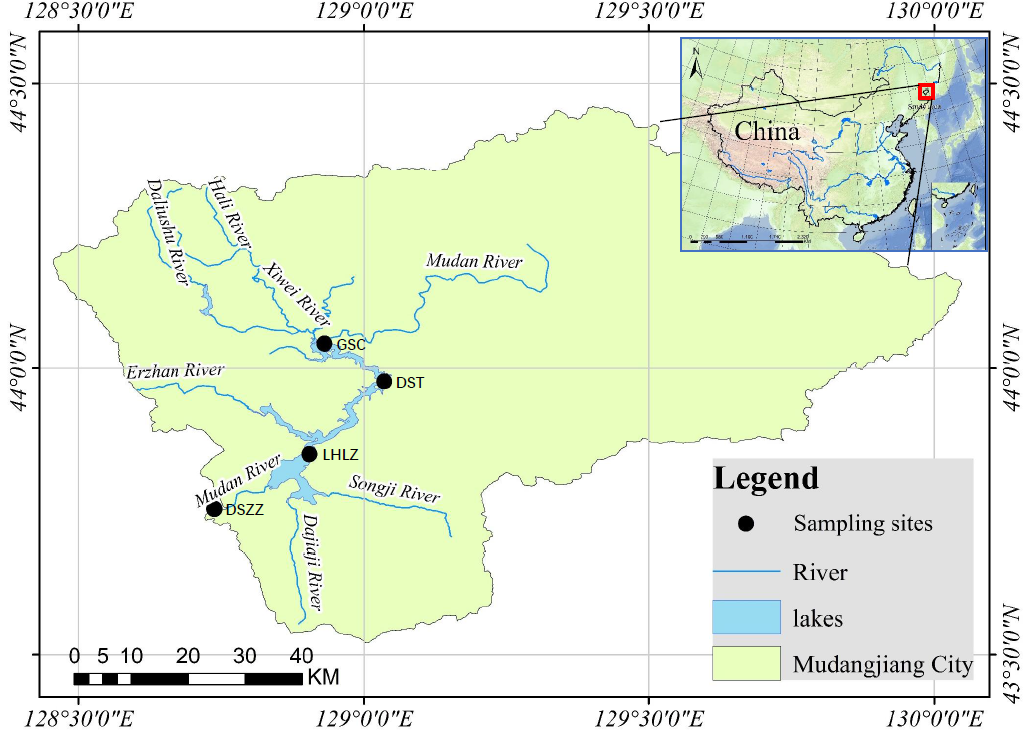
Figure 1. Schematic diagram for Jingpo Lake.